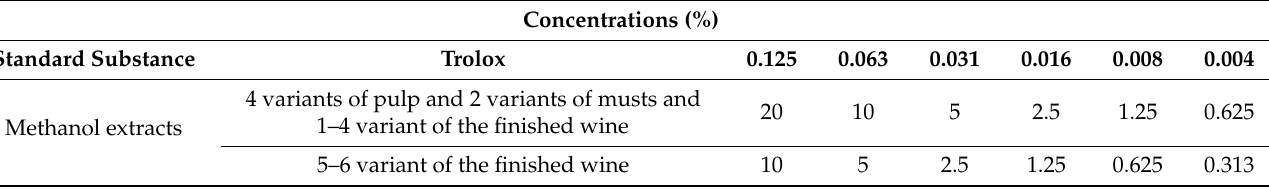
Table A2. Concentrations of extracts and standard substances prepared for testing antioxidant activity with the DPPH reagent